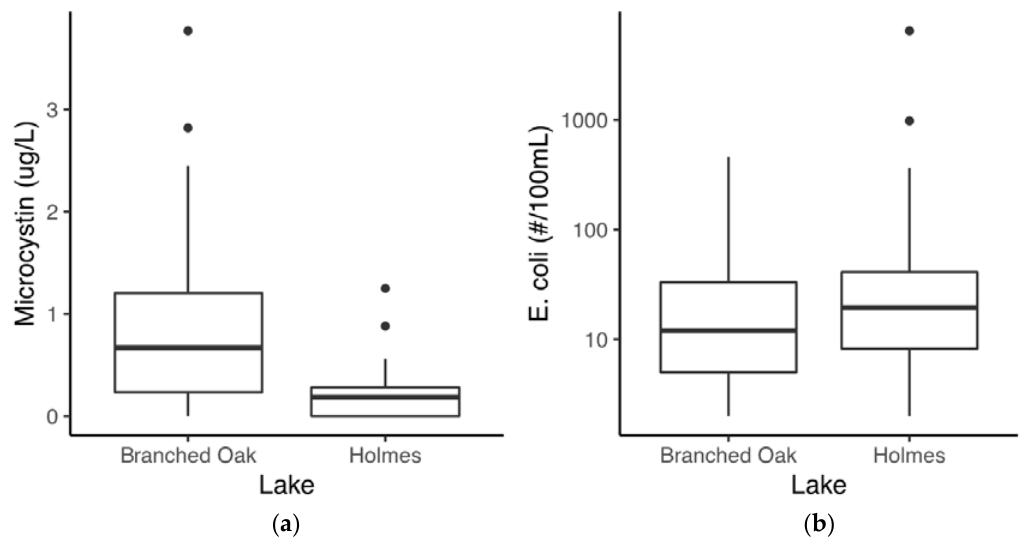
Figure A1. Water quality parameters, based on ( a ) microcystin concentration and ( b ) E. coli counts, in Branched Oak Lake and Holmes Lake during summer 2019. Notice the log scale on (b).